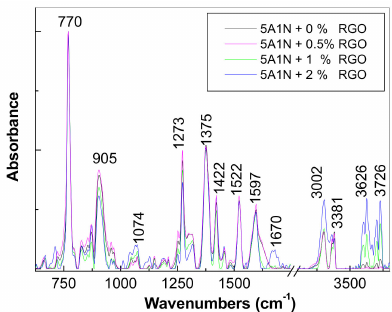
Figure 1. IR spectra of 5A1N (black curve) and the 5A1N / RGO mixtures with RGO sheets concentrations equal to 0.5 wt. % (magenta curve), 1 wt. % (green curve) and 5 wt. % (blue